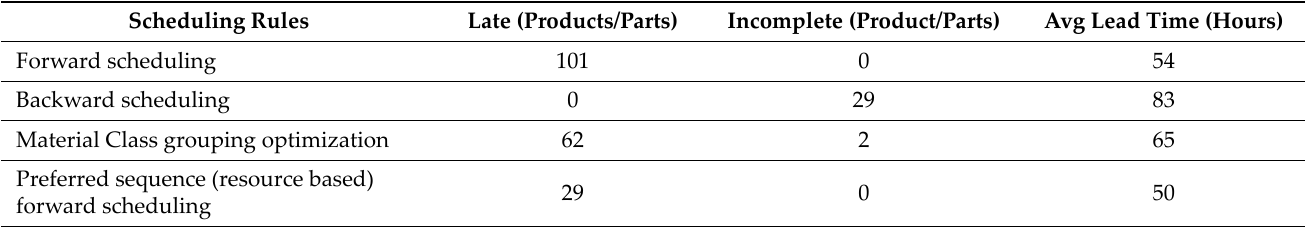
Table 1. Comparison of scheduling operations and its